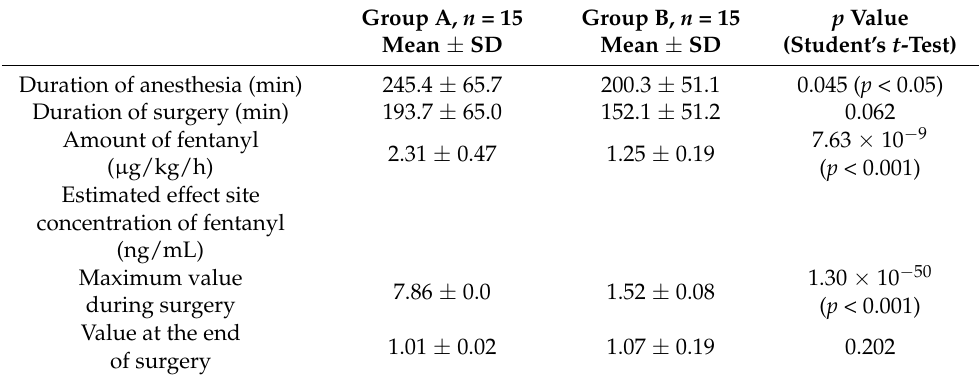
Table 2. Surgery time and estimated effect site concentration of fentanyl.